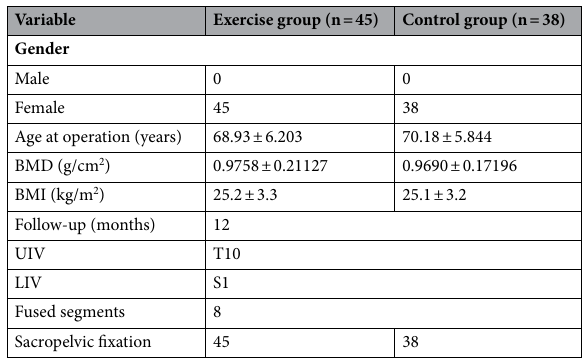
Table 1. Demographics and baseline data. Data are presented as mean ± standard deviation or number. BMD bone mineral density, BMI body mass index, UIV uppermost instrumented vertebra, LIV lowermost instrumented